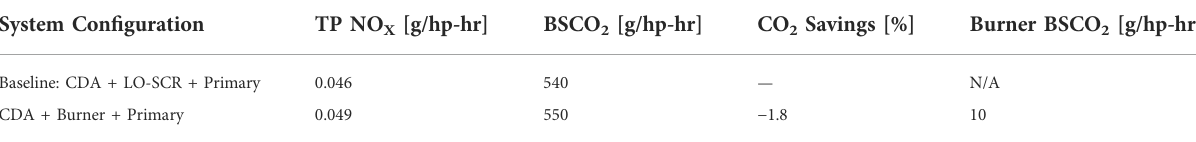
TABLE 5 Cold start HD-FTP results comparison between baseline and CDA + Burner + Primary system.